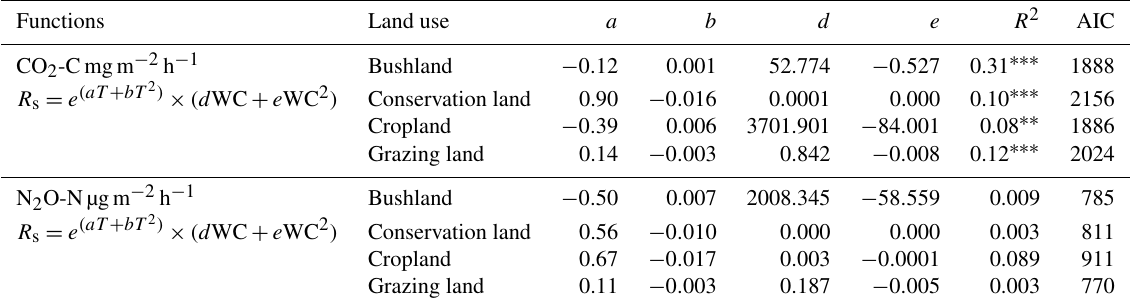
Table 3. Combined effects of soil water content (WC) and soil temperature ( T ) control on soil CO 2 and N 2 O emissions. Soil CO 2 and N 2 O emissions are denoted by R s , while a , b , d , and e signify the model coefficients, R 2 is the coefficient of determination, and AIC is the Akaike’s information criterion.